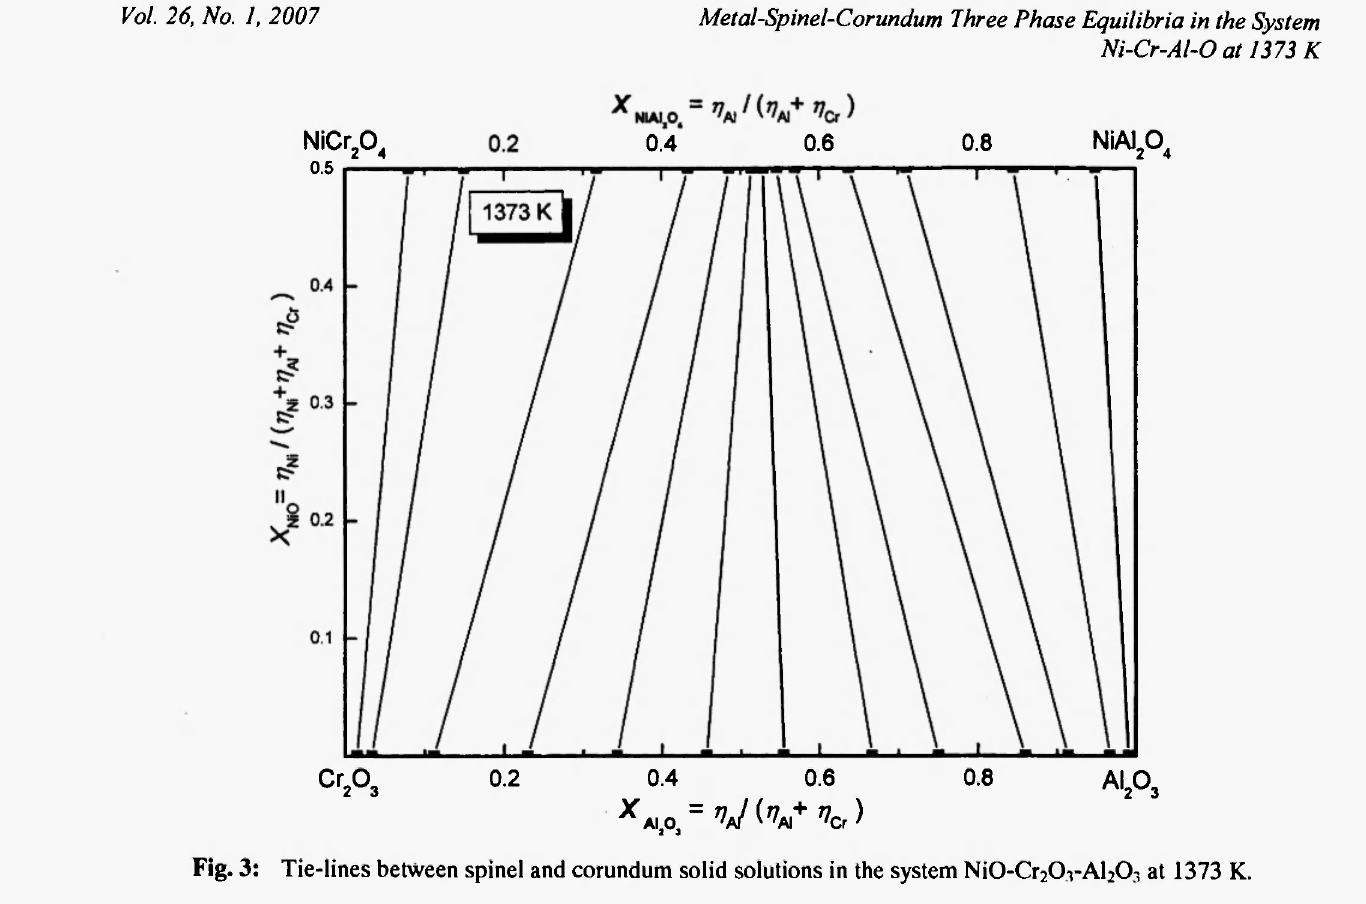
Fig. 3: Tie-lines between spinel and corundum solid solutions in the system Ni0-Cr 2 0-rAl 2 03 at 1373 K.